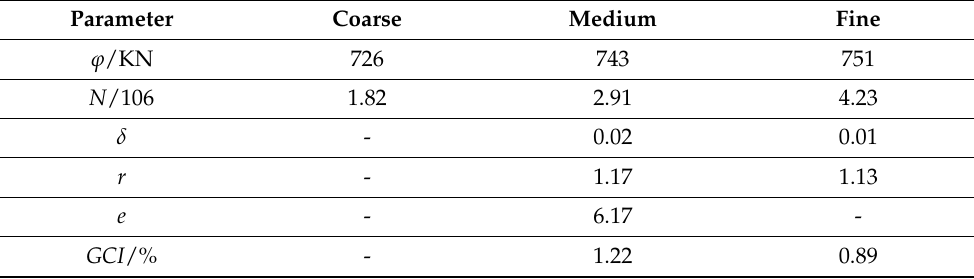
Table 3. Grid independence